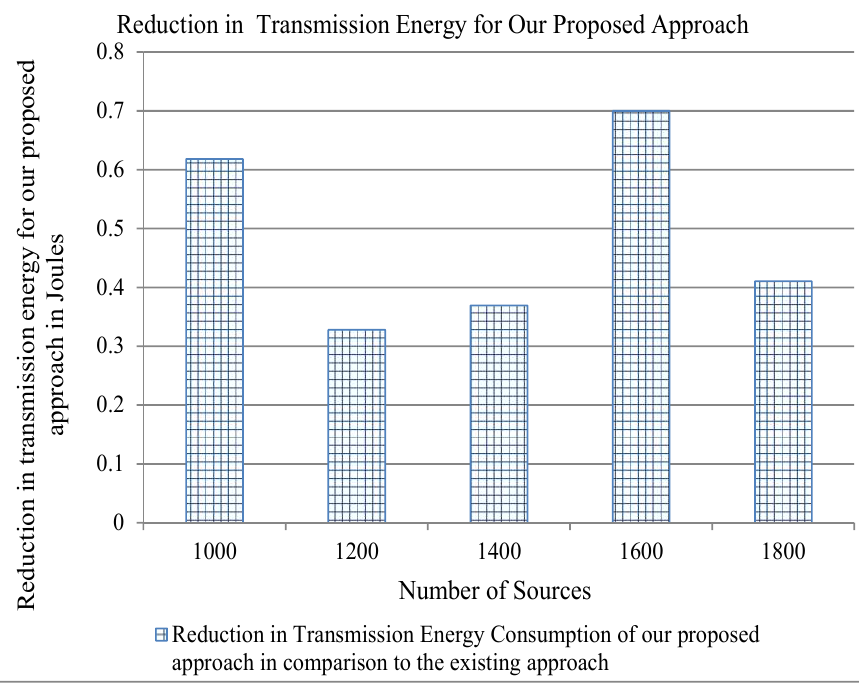
Figure 10. Reduction in Transmission Energy for our proposed approach in comparison to the existing for three cache